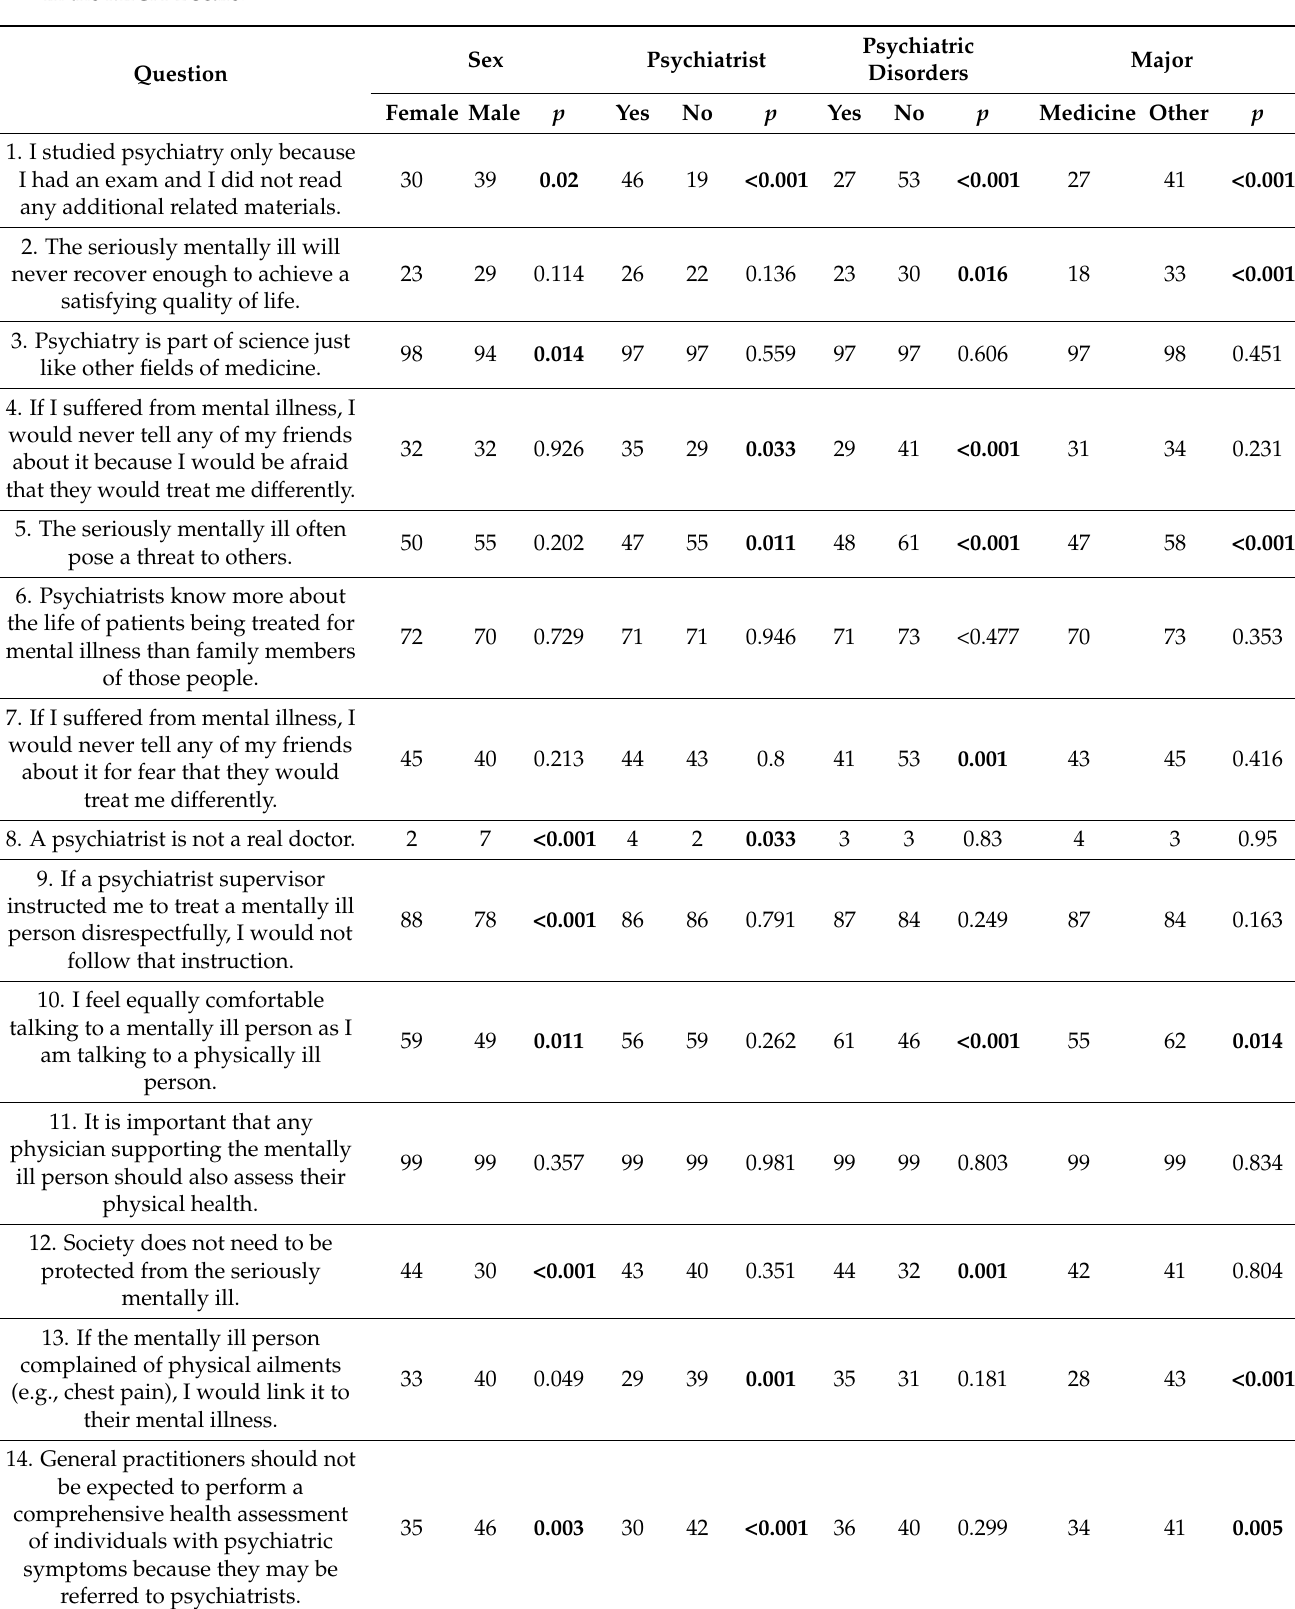
Table 5. The percentage of positive responses (“I strongly agree”, “I agree”, and “I rather agree”) to each question addressed in the MICA-2